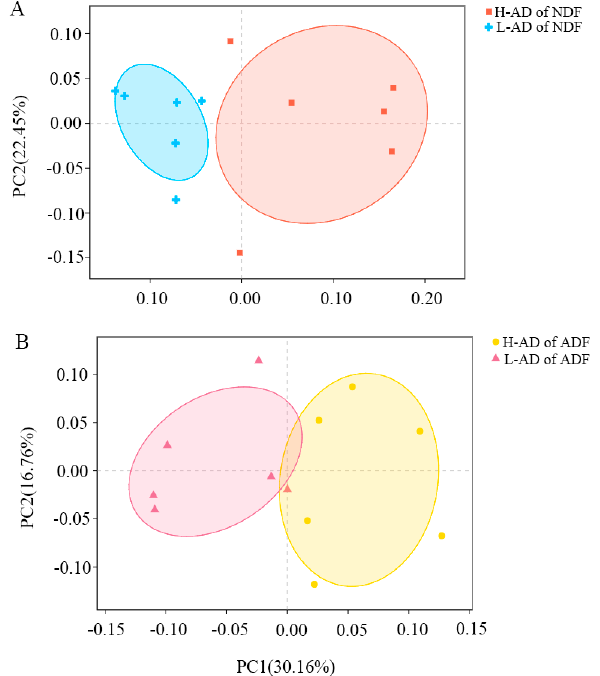
Figure 2. PCoA of H- and L-AD of NDF and ADF samples, respectively. PCoA was generated by using weighted UniFrac distance between H- and L-AD groups in NDF and ADF. The first principal coordinate separated H- and L-AD of NDF samples, explained 51.49% of sample variation ( A ). The first principal coordinate, explained 30.16% of sample variation, separated H- and L-AD of ADF samples ( B ).